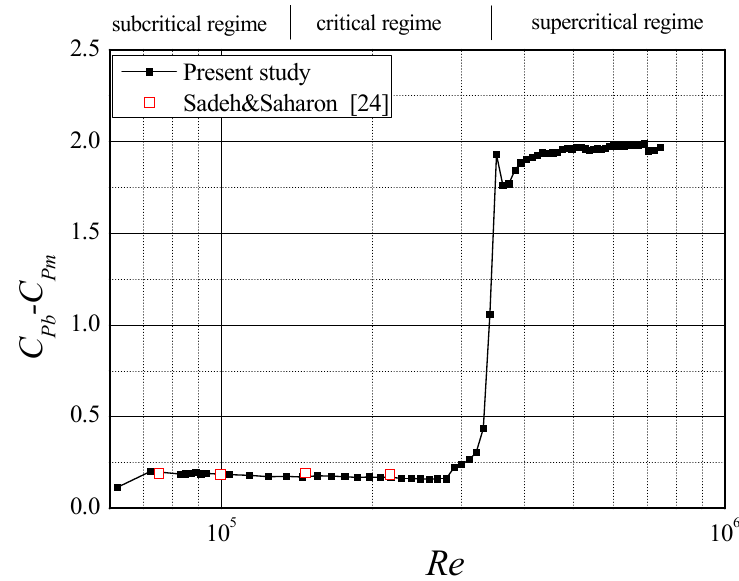
ffi cient ( C pb - C pm ) in the smooth flow.